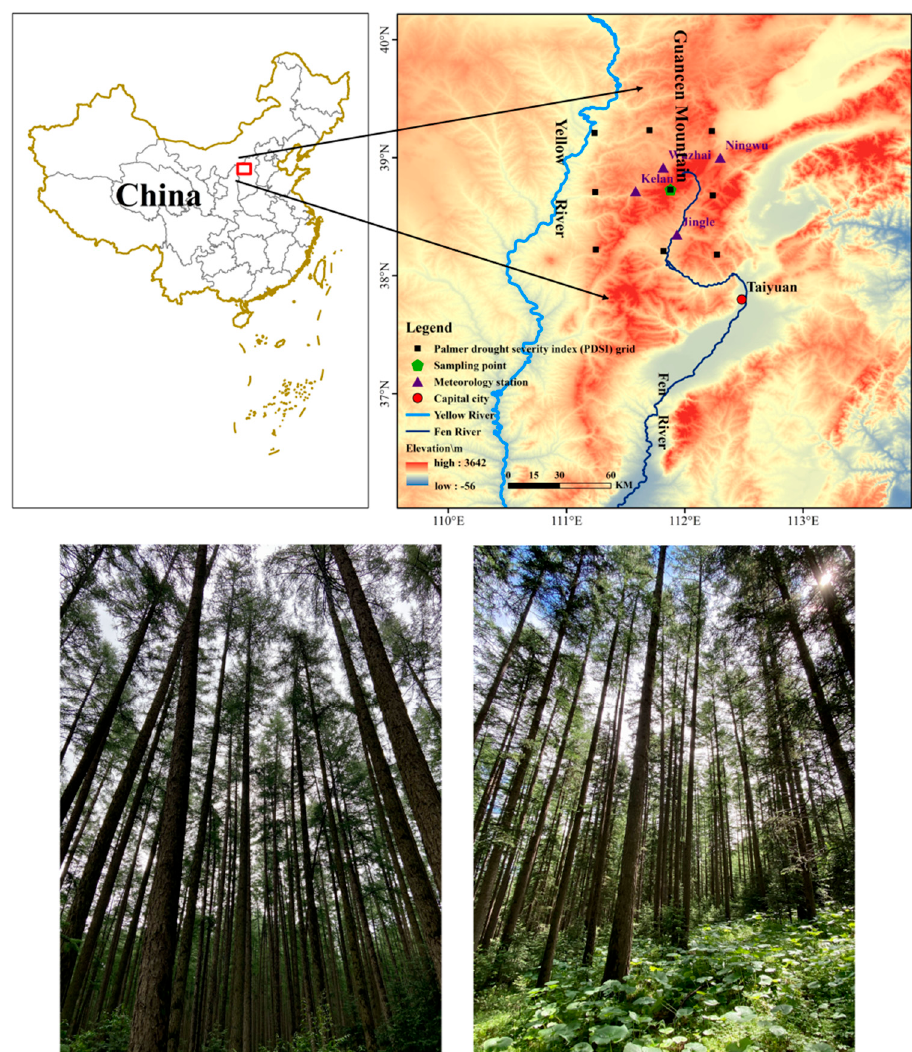
Figure 2. Locations of the L. principis-rupprechtii tree-ring sampling point and weather stations on Guancen Mountain.